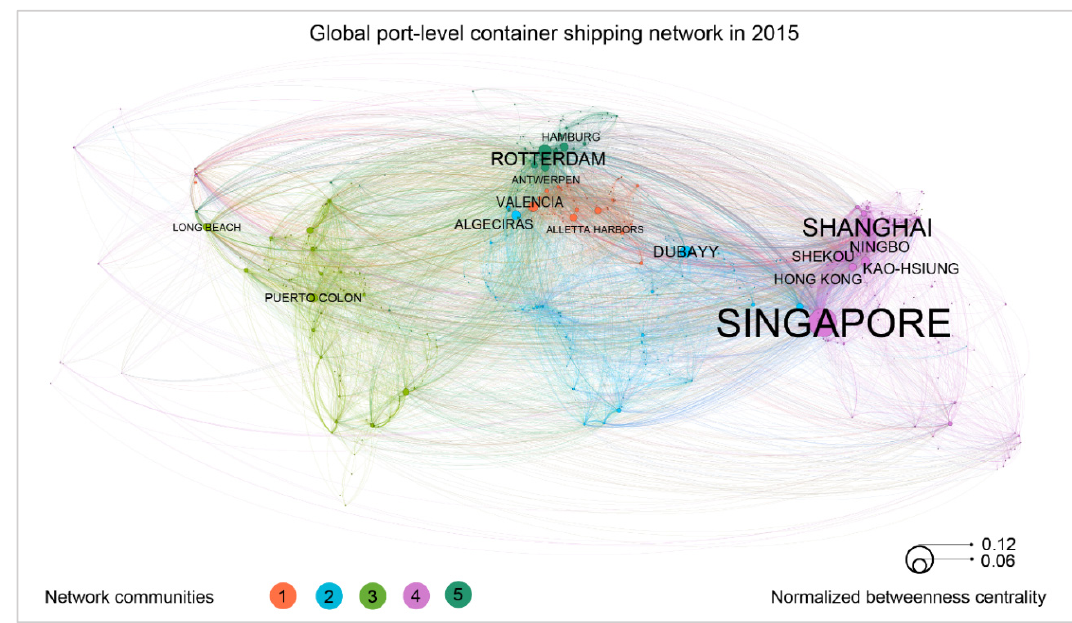
Figure 9. Port level Global Container Shipping Network (GCSN) extracted from ship AIS data in 2015. A directed and weighted network with 9227 links and 513 port nodes located in 150 countries. The size of a node refers the normalized betweenness centrality of a given node. The color refers to the five community clusters of the network. The color of a link is equal to the color of its departure node. The width of a link is equal to a rescaled link weight.